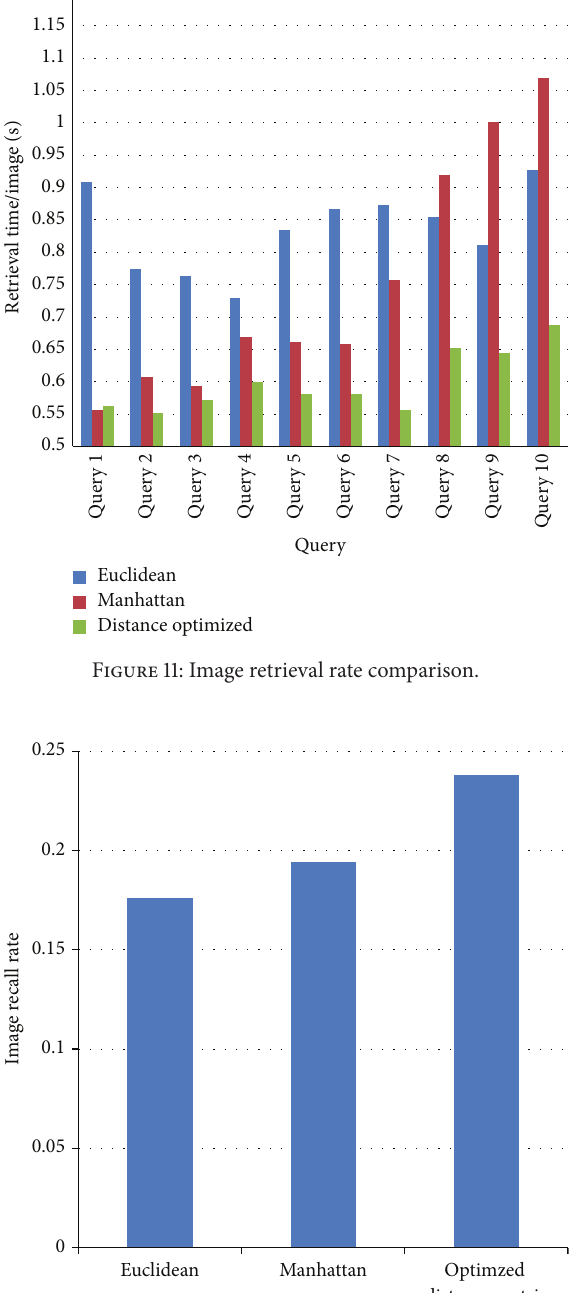
Table 1: Database clustering for different 𝐾 values.